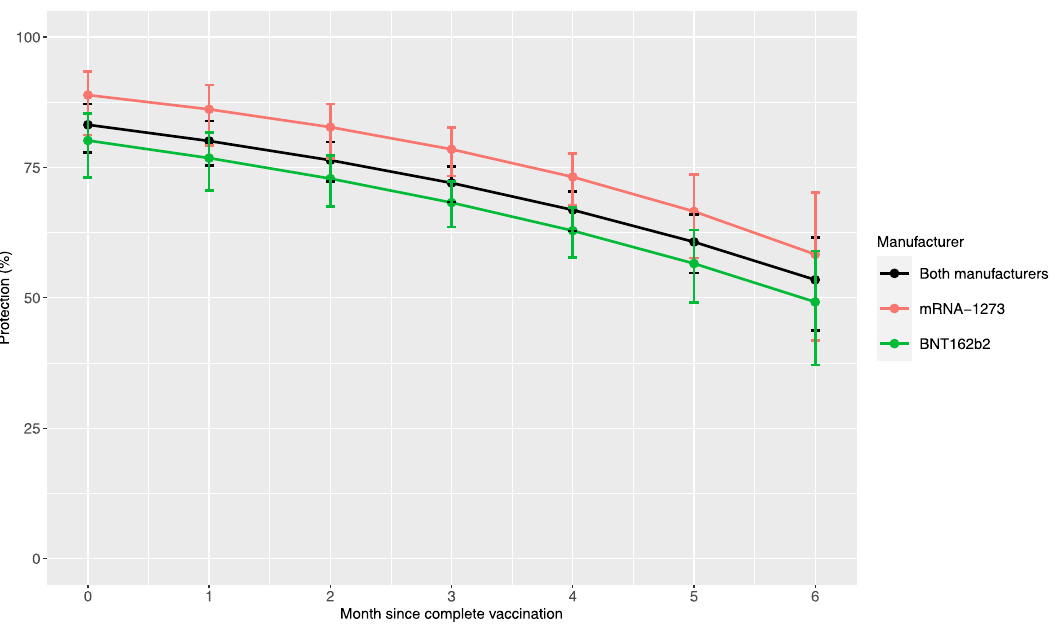
Fig. 2 Time-varying protection from mRNA vaccination. Adjusted estimated vaccine protection (point estimate with 95% CIs) by months since full vaccination for mRNA-1273, BNT162b2, and any mRNA